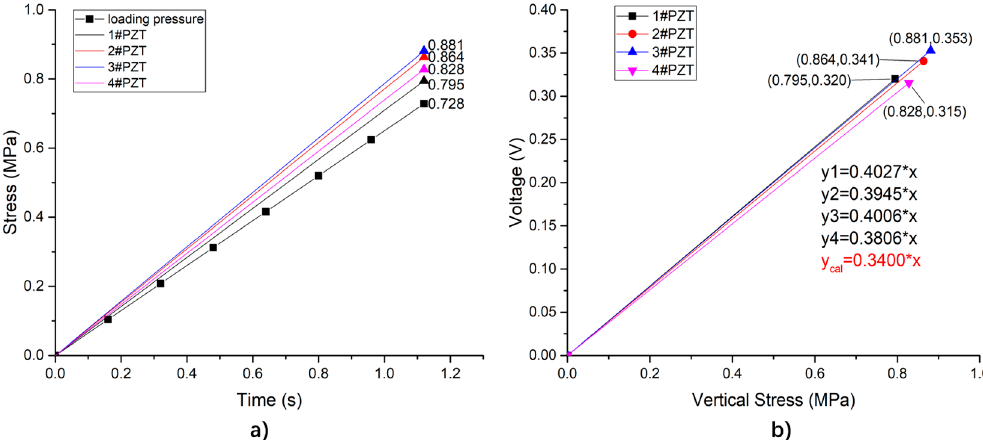
Figure 13. The piezoelectric sensing units under uniform load. ( a ) Vertical stress of each piezoelectric element; ( b ) comparison of analog sensitivity and theoretical sensitivity of each piezoelectric element.